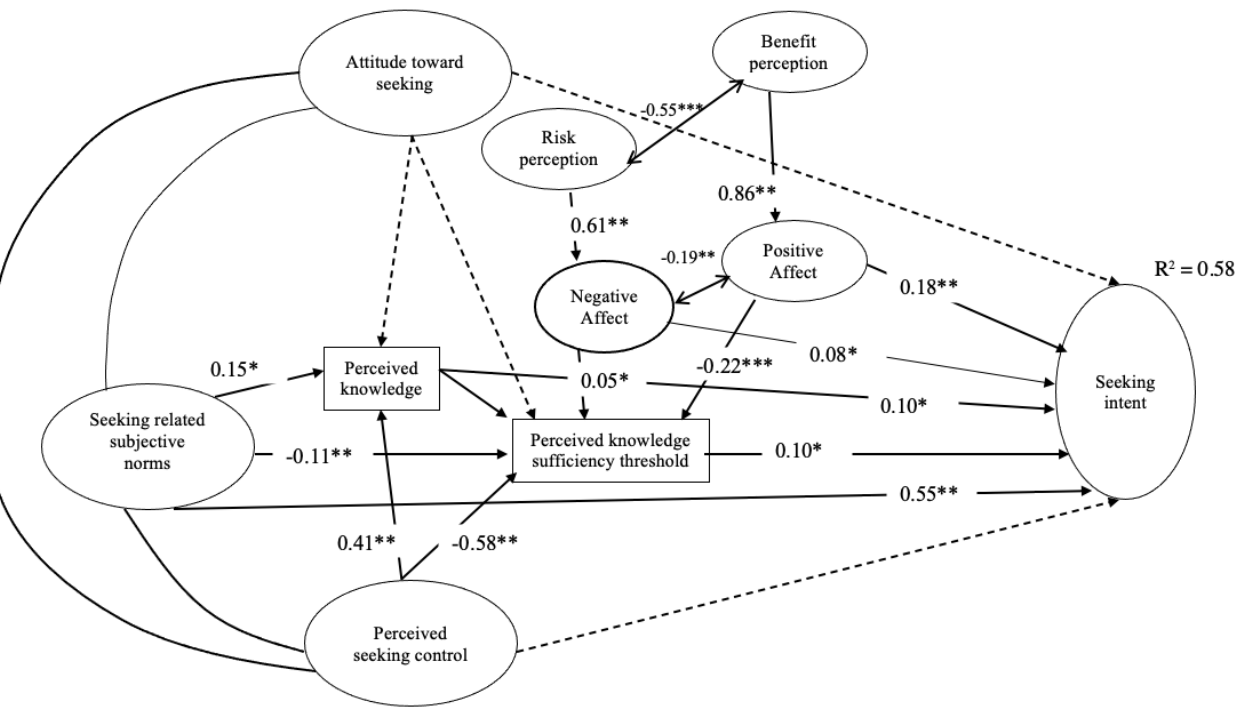
Figure 2. Structural equation model of PRISM with benefit and positive affect. Dotted lines represent insignificant paths. * p < 0.05. ** p < 0.01. *** p < Table 4. Relationship Coefficients ( β ) and Corresponding p -values.